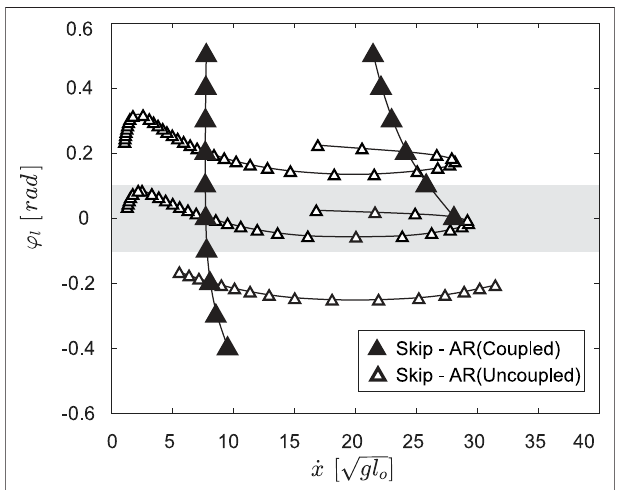
FIGURE10| Theskip-asymmetricalrun(AR)transitionsforthecoupled model, φ r (cid:2) φ l ∈ [− 0 . 5 , 0 . 5 ] , vary slightly with speed and occur in two narrow ranges of speed. The uncoupled model, φ r =[ − 0.2,0,0.2], fi nds far more solutions for the same type of gait transition throughout a broader speed range.